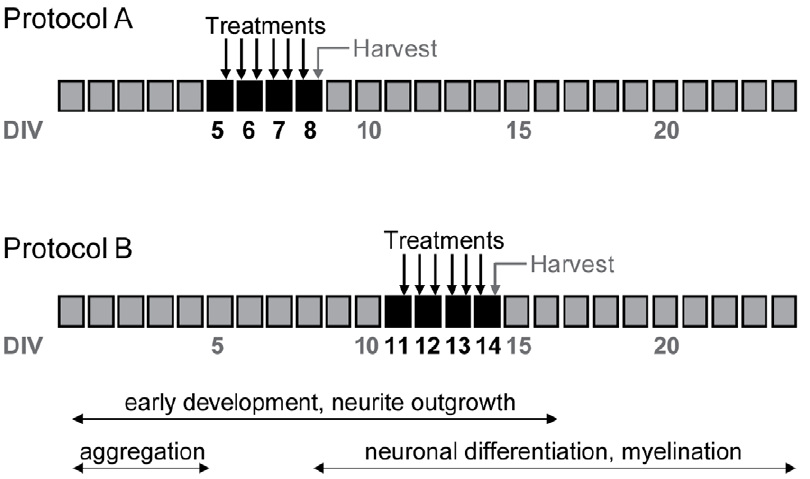
Figure 1. Treatment protocols. Cultures of aggregates were exposed to 1 mM GA and 3-OHGA at two time points representing different developmental stages of brain cell maturation (Protocols A and B). Metabolites were added 6 times every 12 hours (indicated by arrows) starting on DIV 5 in protocol A and on DIV 11 in protocol B (treatment days are indicated by black boxes) 12 hours after the change of the medium. Aggregates were harvested 5 hours after the last treatment at DIV 8 in protocol A and at DIV 14 in protocol B.